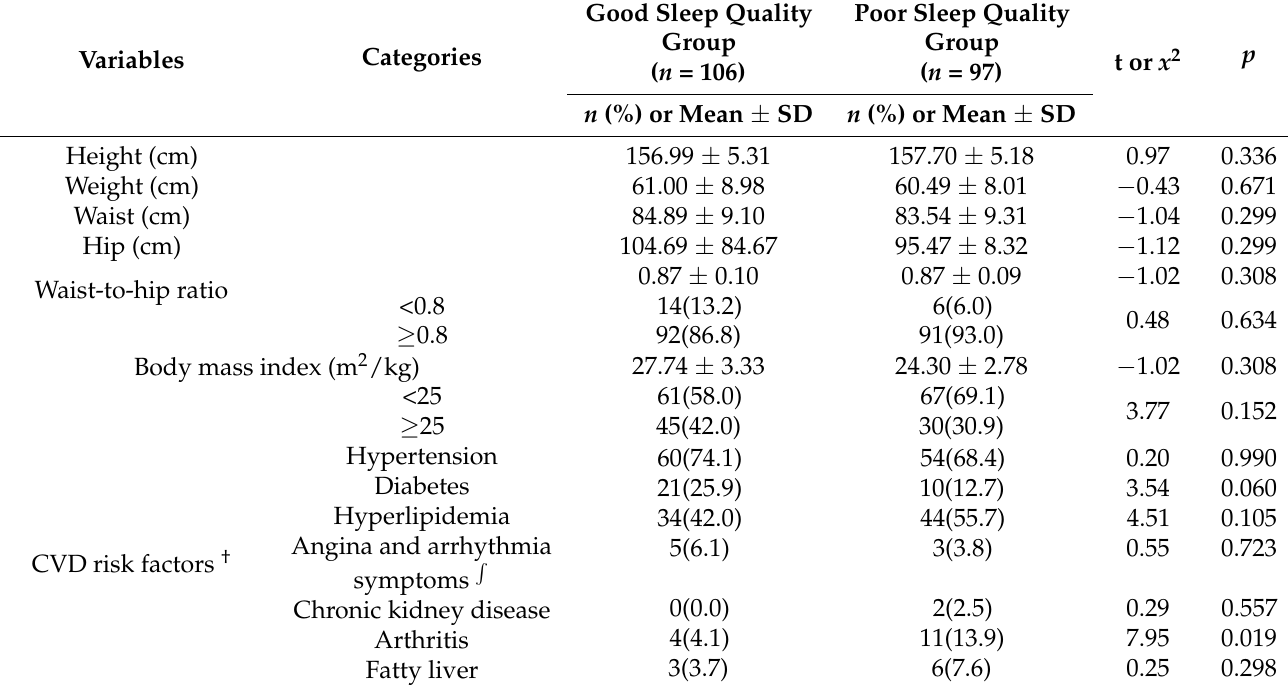
Table 2. Cardiovascular disease-related characteristics of the participants. ( N =